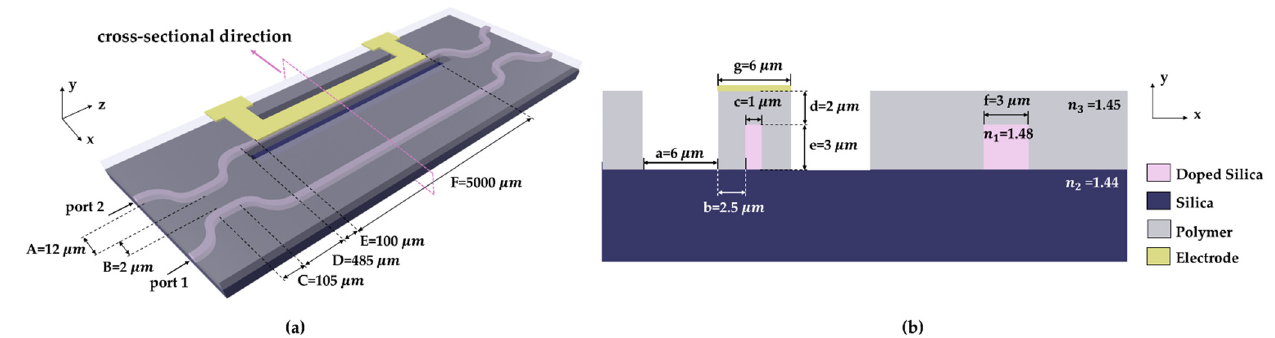
Figure 1. The structure of the silica/polymer hybrid thermo-optic switch in ( a ) a three-dimensional direction and ( b ) a cross-sectional direction, including heating arm, non-heating arm, air trenches, and electrode. A, B, C, D, E, and F are the offset of the bend waveguide, the waveguide spacing in the directional coupling area, the length of the straight waveguide, the length of the bend waveguide, the length of the taper waveguide, and the length of the electrode.